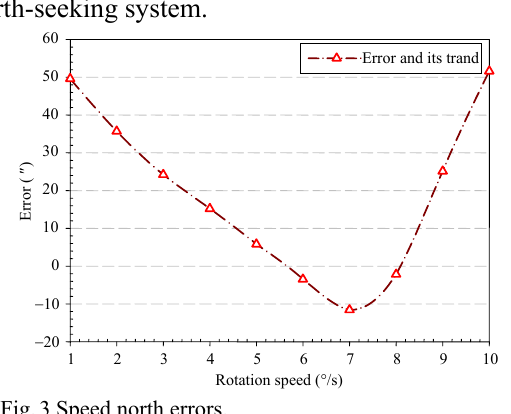
Fig. 3 Speed north errors.